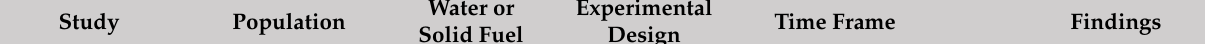
Table A2. Gender disparities in water and solid fuel collection and